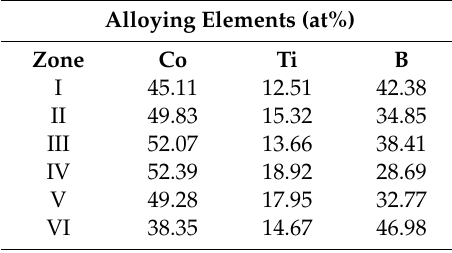
Figure 7. ( a ) FE-HRTEM of (Co 75 Ti 25 ) 70 B 30 powders obtained after 50 h of MA time, ( b ) atomic resolution transmission electron microscope (TEM) image taken from the zone indexed by a circular symbol in ( a ), and ( c ) NBDP corresponding to ( b ). The results of EDS-elemental analysis for the spots indexed by Roman numbers (I, II, III, IV, V, and VI) are presented in Table 3. Table 3. FE-HRTEM/EDS elemental analysis of selected spots shown in Figure 7a.